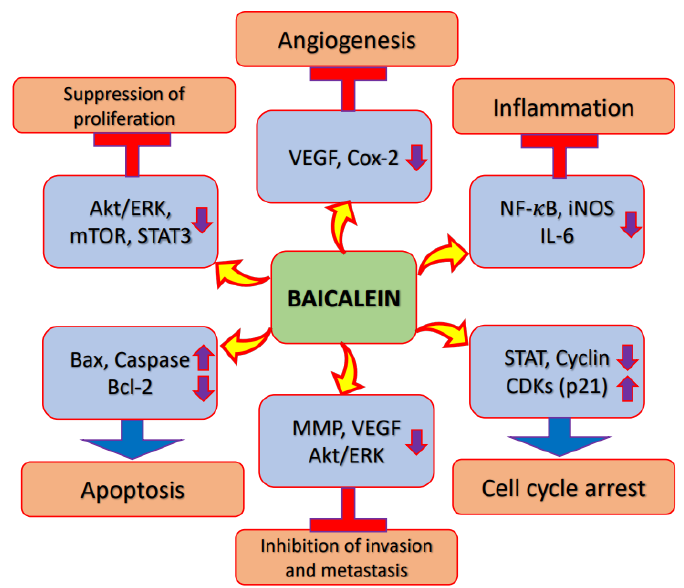
Figure 2. Anticancer effects of baicalein through the modulation of cell signaling